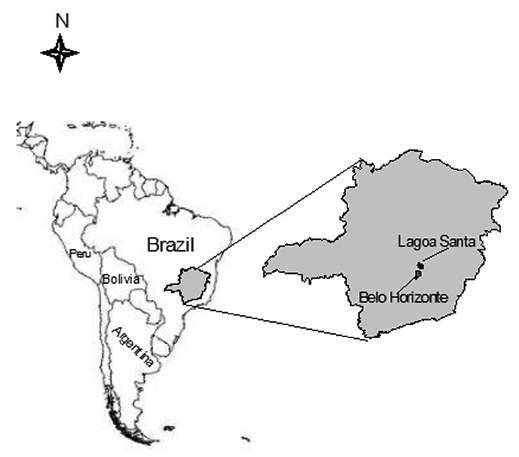
Figure 1. Localization of Lagoa Santa town, Minas Gerais state,